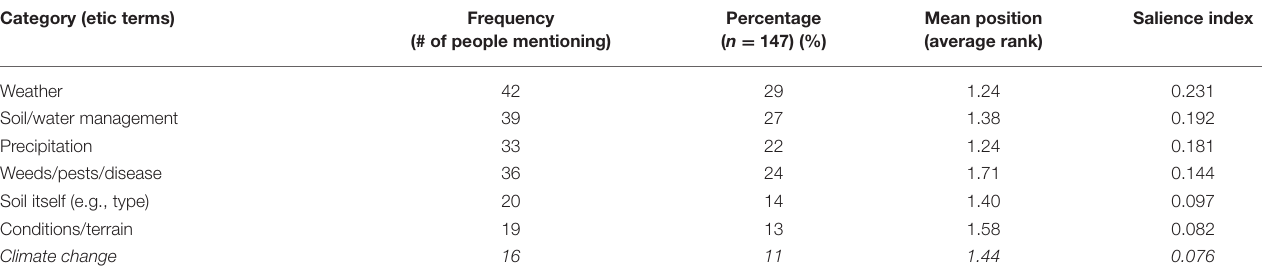
TABLE 3 | Research question 1: Respondents’ top two natural challenges posed by the physical environment to their farms: free list analysis of mean position and salience.